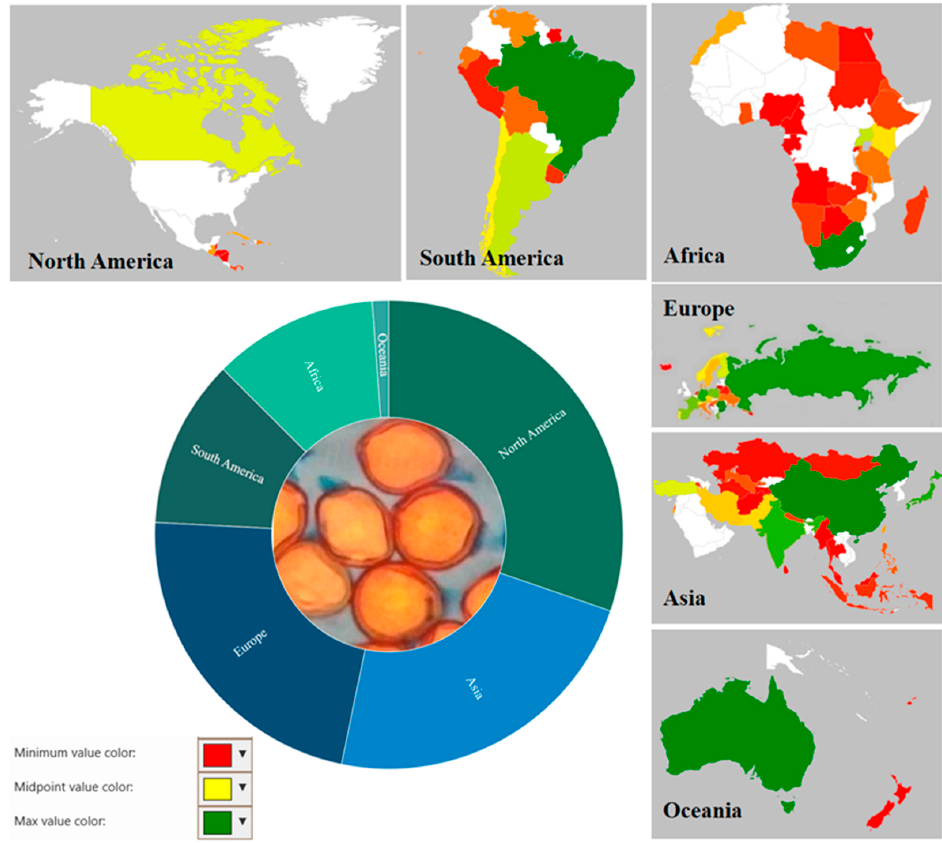
Figure 6. Heat maps to show the continental distribution and species richness of Uromyces spp.